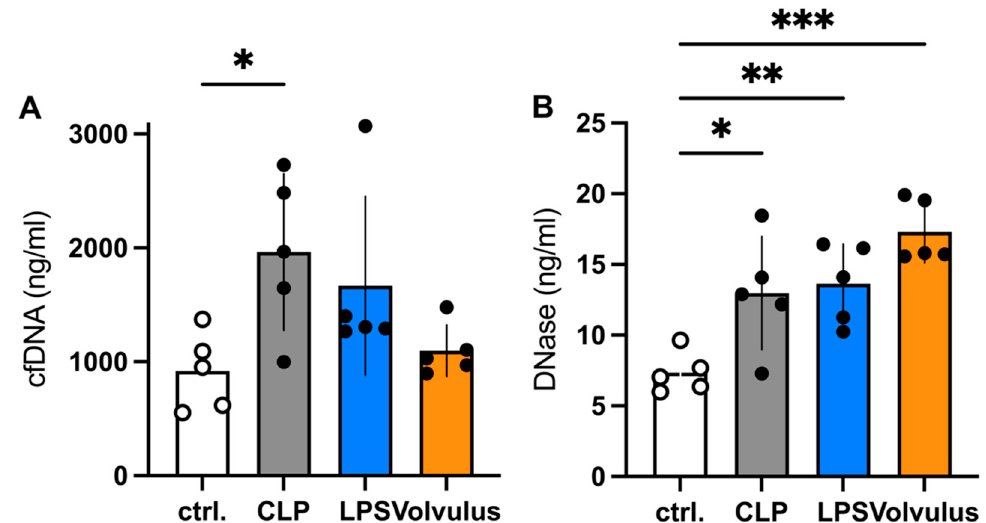
Figure 2. The NET markers cfDNA and DNase I in the blood of mice succumbed to murine models of septic conditions. ( A ) cfDNA and ( B ) DNase plasma levels 48 h after intervention. n = 5 per groups. Note, whereas the DNase I was the highest in the volvulus model the cfDNA was close to the controls. Data shown as mean ± SD. * p < 0.05, ** p < 0.01, *** p < 0.001. ANOVA with Dunnett’s correction.